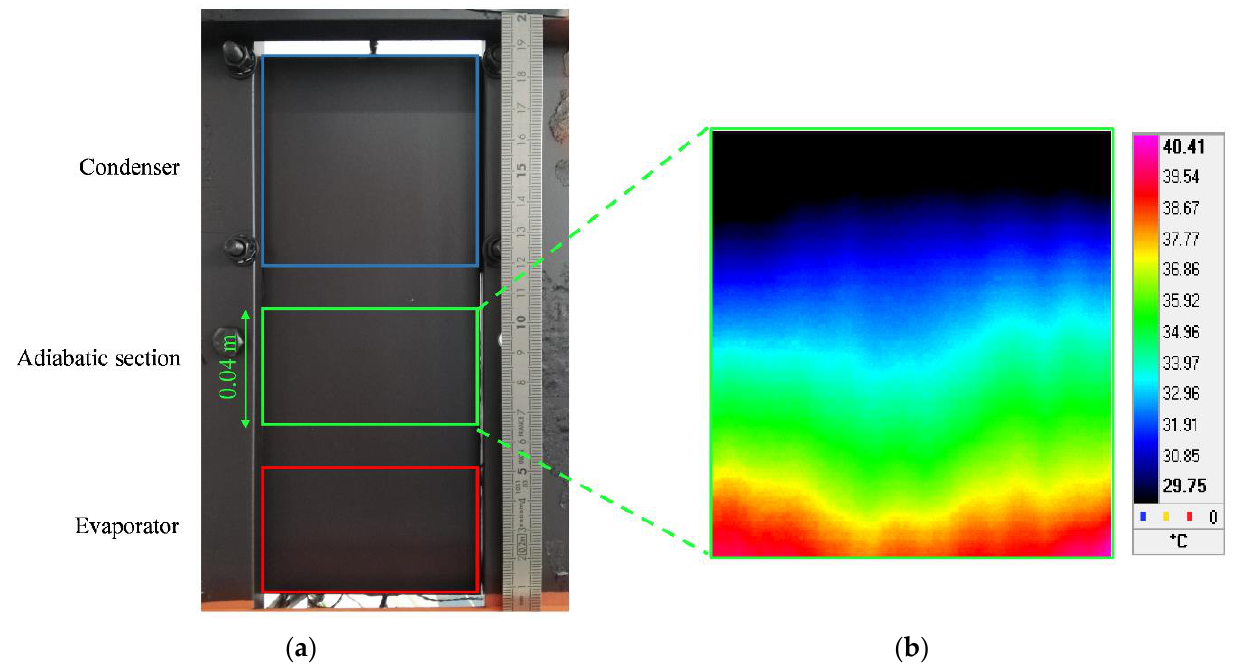
Figure 2. Coated front side of the device, with reference to the section framed during the IR analysis (green box) ( a ); representative IR frame ( b ).